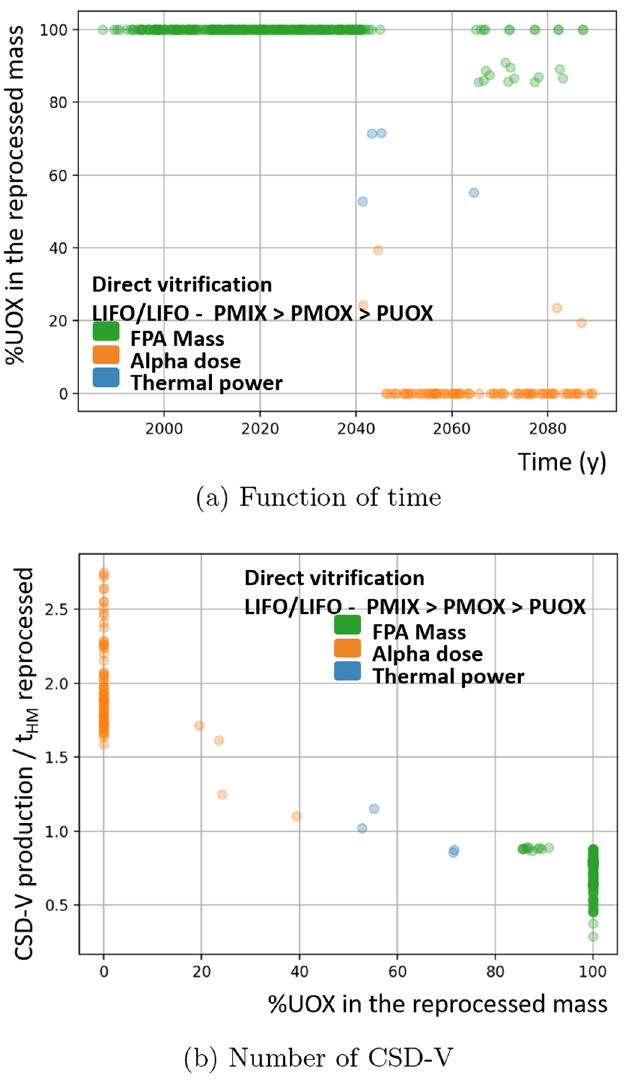
Fig. 12. Limit reached with direct vitrification according to the percentage of UOX fuel in the canister.